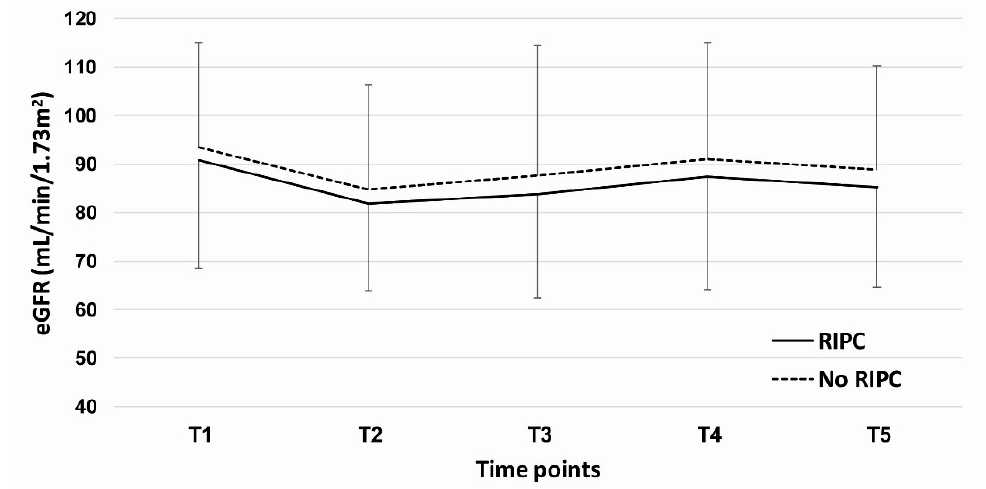
Figure 2. Comparison of time-dependent changes in the serum creatinine between the RIPC and control groups. Time points were defined as preoperative (T1), at post-anesthesia care unit (T2),